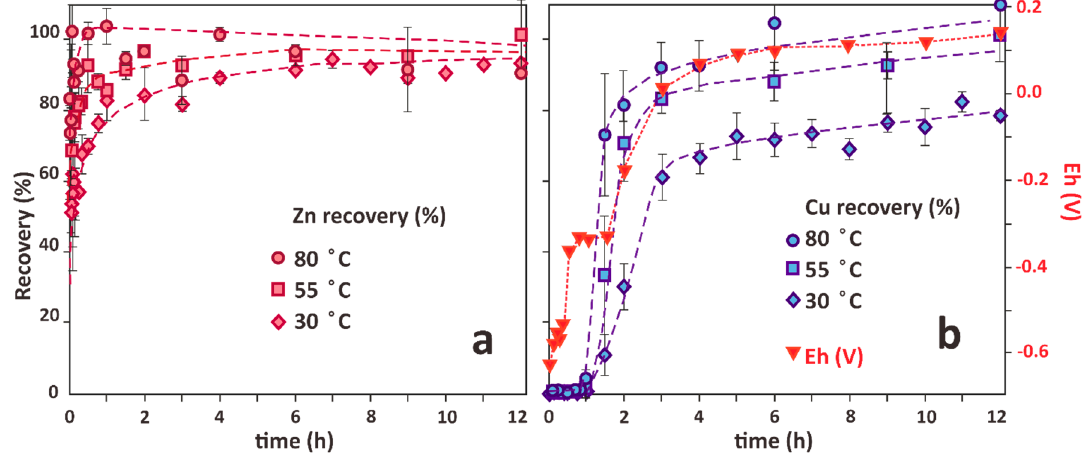
Figure 10. The effect of leaching time and temperature on recovery of ( a ) Zn and ( b ) Cu. In b, the change of Eh in aqueous phase during leaching was obtained at 30 °C (single measurement). Table 5. Correlation coefficient for experimental data fitting using three kinetic models (SCM, shrinking core model; SPM, shrinking particle model).